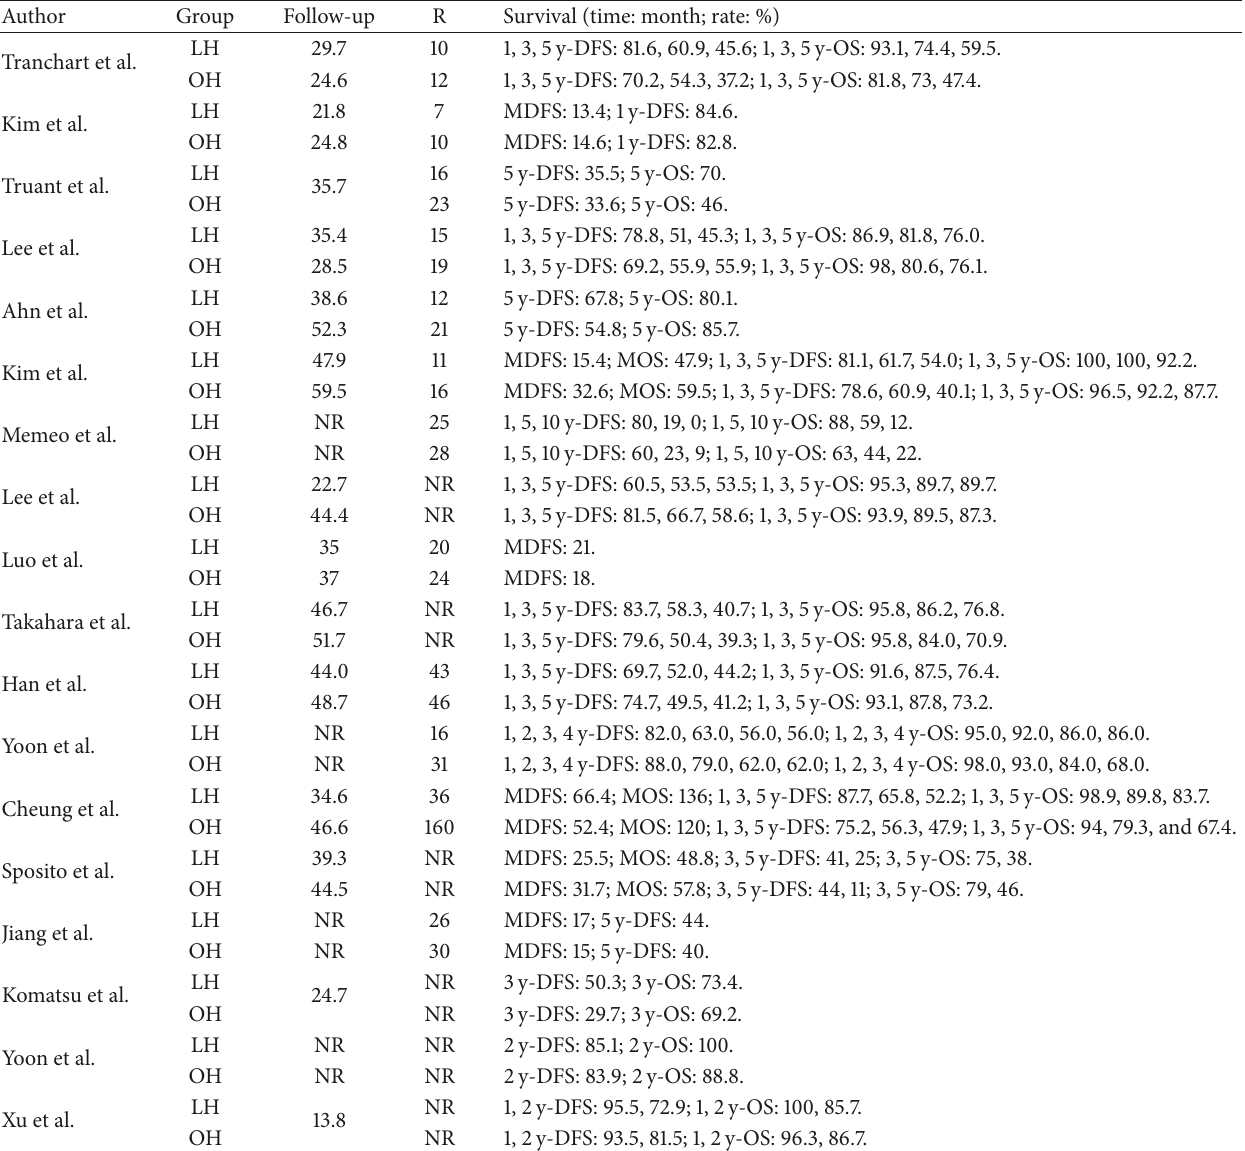
Table 4: Summary of recurrence and long-term